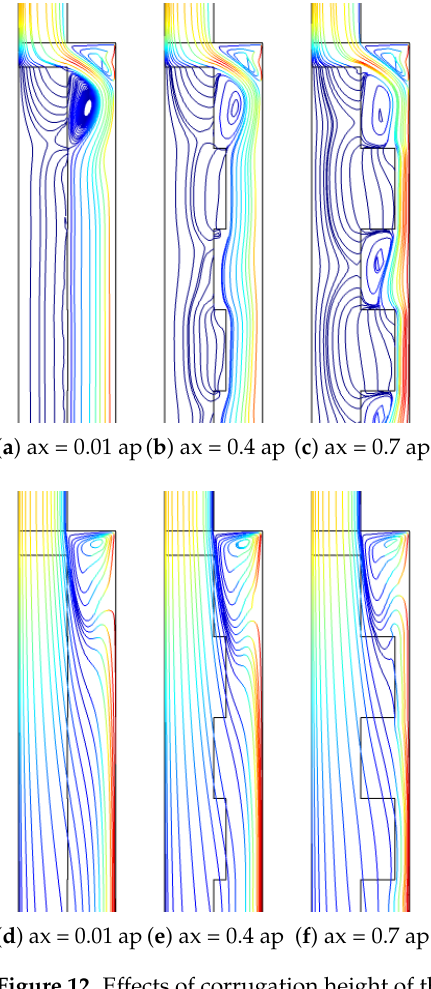
Figure 12. Effects of corrugation height of the PL at two different permeabilities (( a – c ), Da = 10 − 5 ), (( d – f ), Da = 10 − 2 ) (Re = 250, Rew = 1000, Ha = 7.5, N = 4). The impacts of the corrugation geometric parameters on the average Nu and pressure coefficients are effective for the case with the lower permeability of the PL as shown in Figures 13 and 14 with (Re = 250, Rew = 1000, Ha = 7.5). A higher value of the corrugation height results in higher HT and pressure coefficients. This is due to the reduction in the gap between the rotating hot surface and corrugated PL interface where at lower values of Da, local fluid velocity rises, and thermal transport enhances. The PL acts as an obstacle that redirects the main fluid stream toward the hot wall for lower permeability. The HT and pressure coefficients rise by about 42% and 62.8% when increasing the wave amplitude from ax = 0.01 ap to ax = 0.7 ap. However, the amount of rise becomes only 9.7% and 14.46% when the wave number is increased from N = 1 to N = 16. It is seen that the hydro thermal performance can be controlled in a good way by varying the permeability and wavy geometrical parameters of the PL. The permeability of the PL and corrugation amplitude have the highest impacts of the HT and pressure coefficient